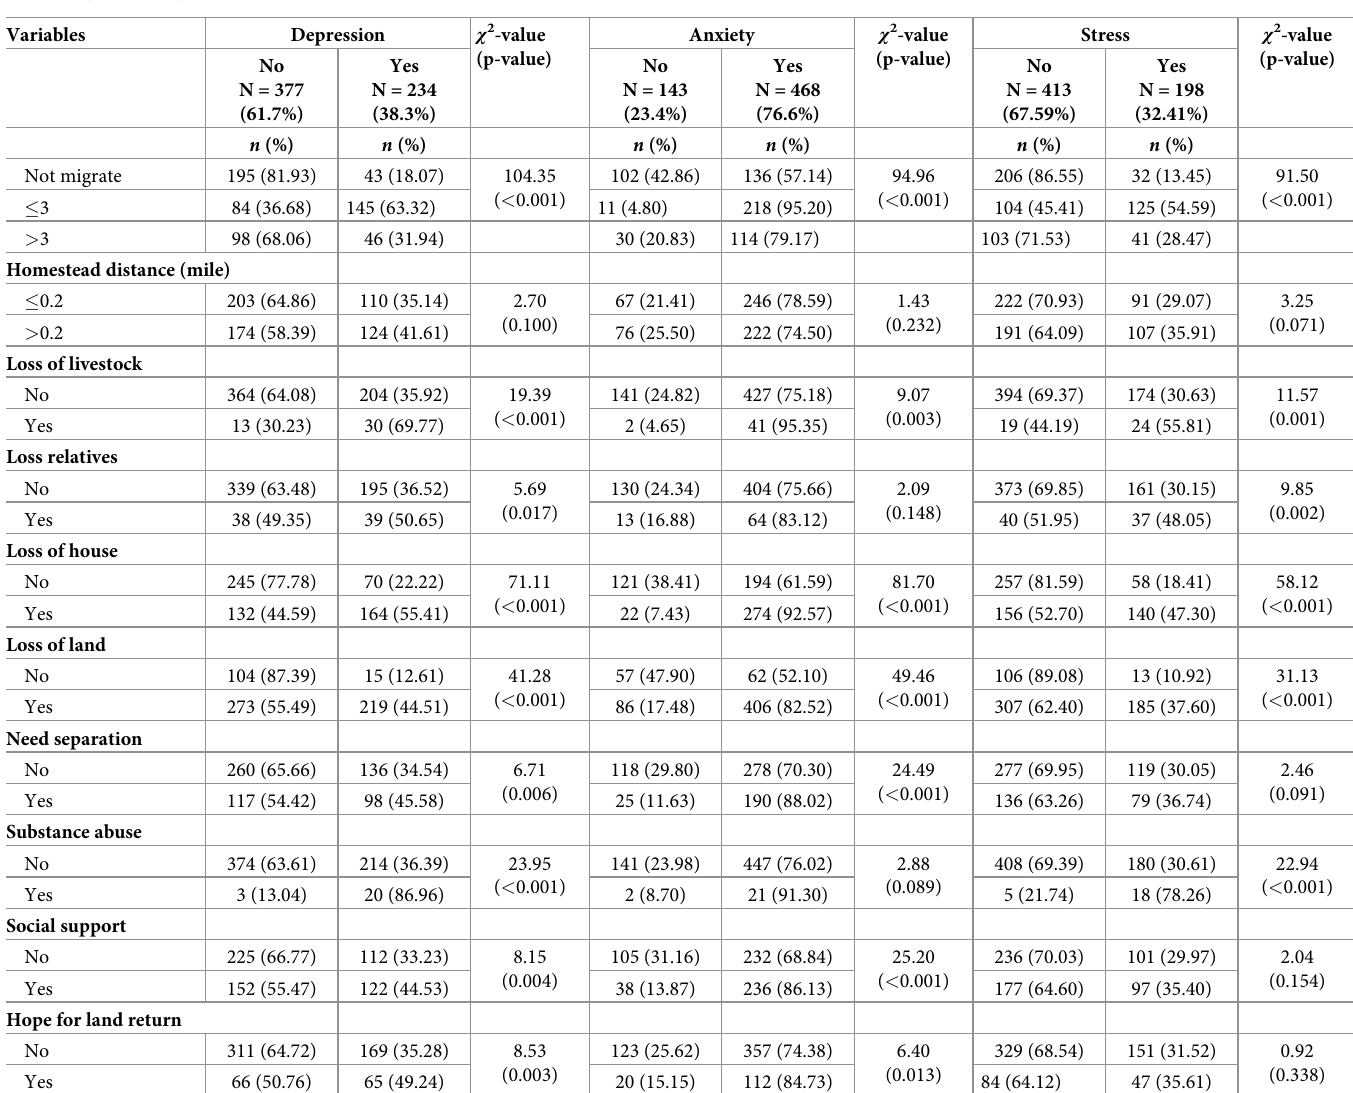
and land (depression: 44.51% versus 12.61%, P < 0.001; anxiety: 82.52% versus 52.10%, P < 0.001; and stress: 37.60% versus 10.92%, P < 0.001) than those who did not lose their rela- tives, livestock, houses, and land. The people who needed separation from family (depression: 45.58% versus 34.54%, P = 0.006; anxiety: 88.02% versus 70.30%, P < 0.001; and stress: 36.74% versus 30.05%, P = 0.091), abused substance (depression: 86.96% versus 36.39%, P < 0.001; anx- iety: 91.30% versus 76.02%, P = 0.089; and stress: 78.26% versus 30.61%, P < 0.001), received social support in terms of borrowing (depression: 44.53% versus 33.23%; anxiety: 86.13% ver- sus 68.84%; and stress: 35.40% versus 29.97%) and had hope for getting back their cultivable land (depression: 49.24% versus 35.28%, anxiety: 84.73% versus 74.38%, and stress: 35.61% versus 31.52%), exhibited higher rate of depression, anxiety and stress disorder in the river ero- sion prone